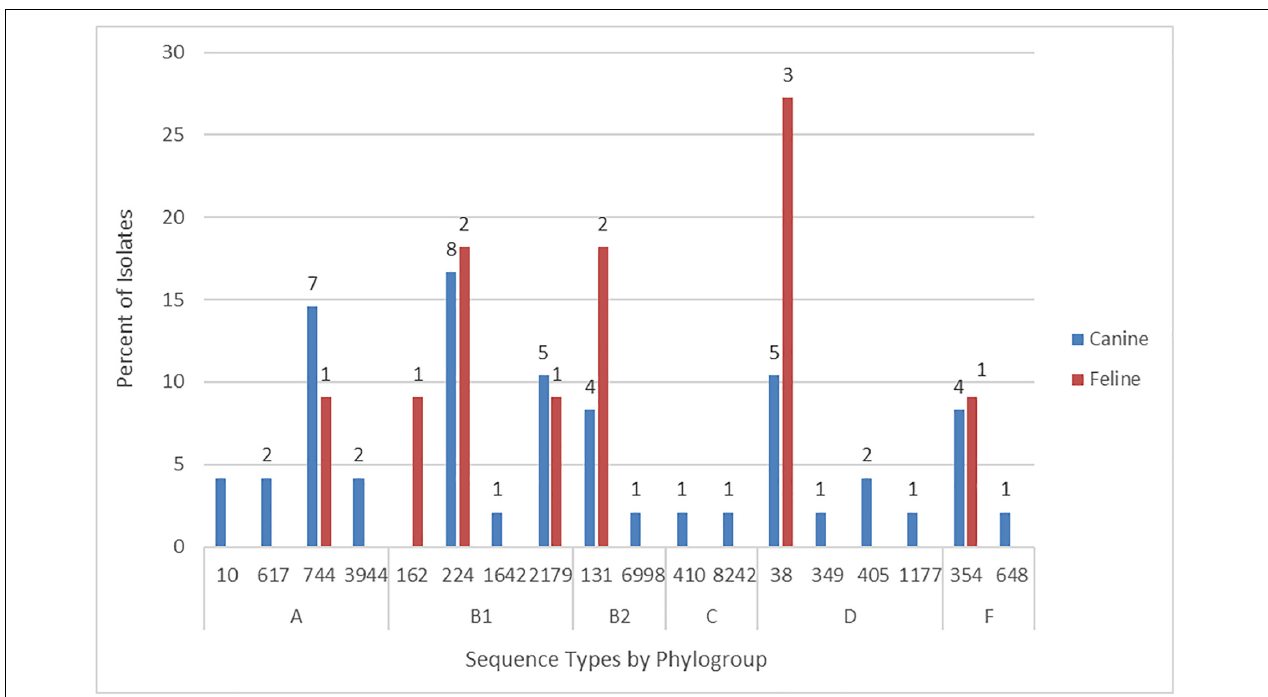
FIGURE 1 | Sequence type frequency among 59 fluoroquinolone-resistant cat and dog clinical Escherichia coli isolates that underwent whole genome